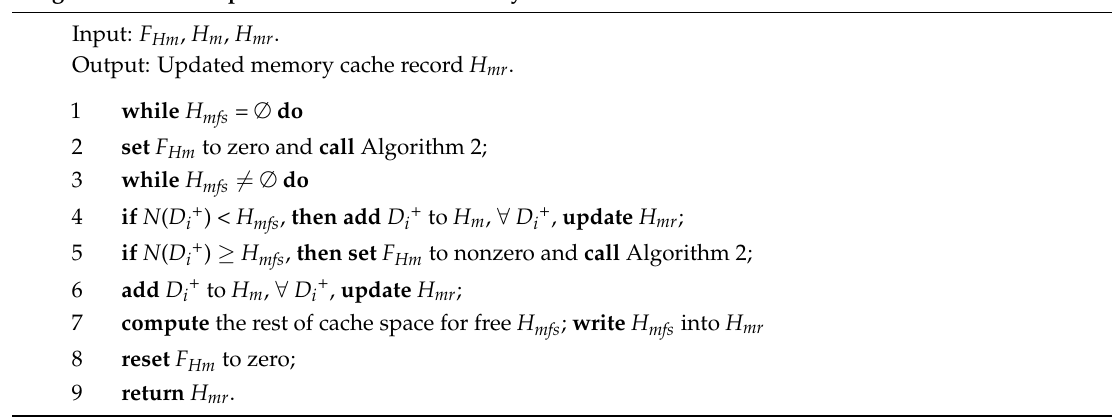
Algorithm 4. Add up-to-date data to the memory